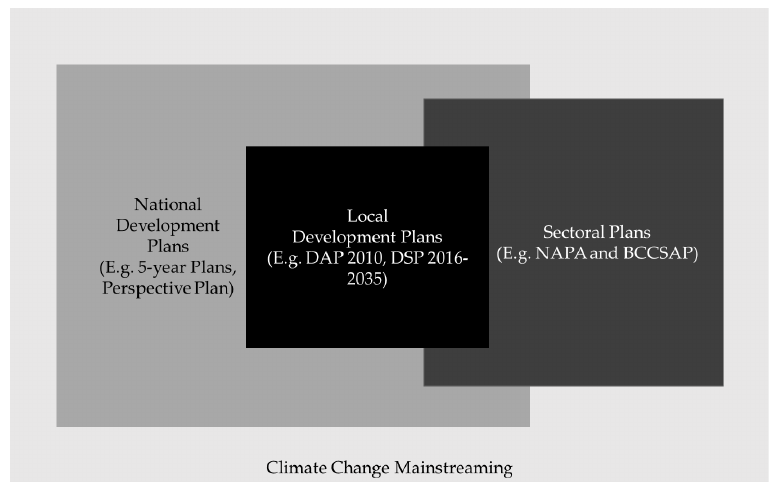
Figure 1. Multi-level climate governance and climate change mainstreaming for Bangladesh.